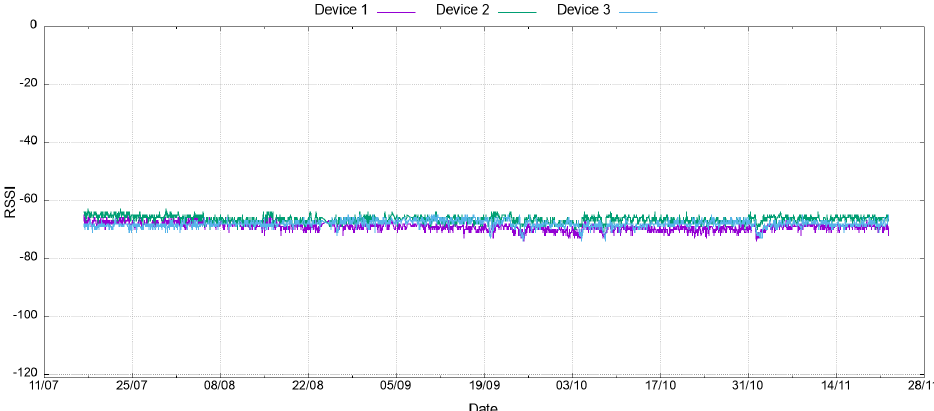
Figure 5. wM-Bus smart meter devices with stable RSSI (Location 1).